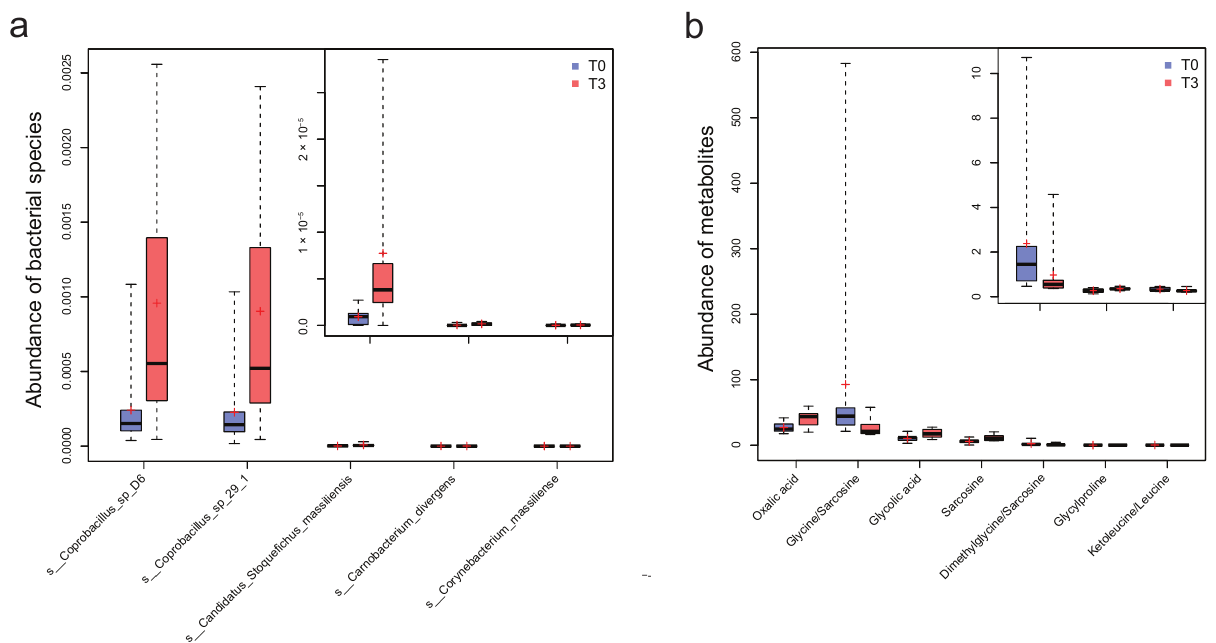
Figure 2. The significantly varied species and metabolites accompanying probiotic supplementation. ( a ) The five differential species throughout the intervention (T3 vs. T0) identified by the Wilcoxon rank-sum test ( p < 0.05) and Kruskal–Wallis test ( p < 0.05), with the incorporation of T6 samples after probiotic discontinuity. ( b ) The seven differential metabolites (T3 vs. T0) identified by Wilcoxon rank-sum test ( p < 0.05). Samples in the T3 group are shown in red, and samples in the T0 group are shown in